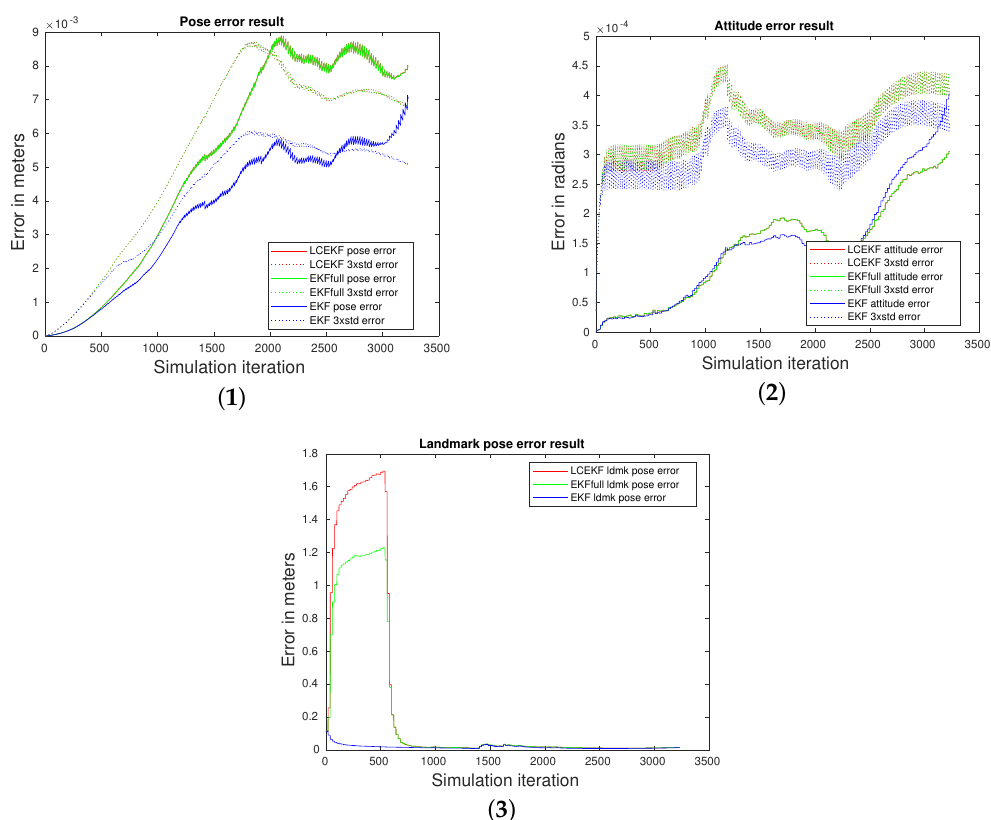
Figure 5. SLAM without noise (Case i): methods’ comparison. ( 1 ) and ( 2 ) represent respectively the MSE of the pose and attitude estimation over 100 executions. Full lines are the mean of the estimation, and dotted line represent the 3 sigma values. ( 3 ) represents the MSE of the landmark convergence during the